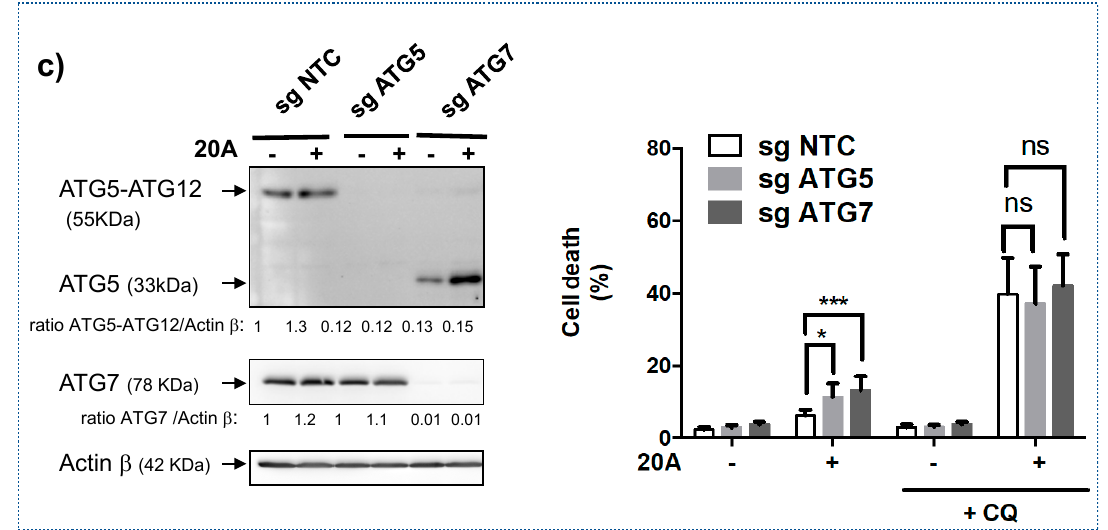
Figure 3. 20A and chloroquine act in concert to trigger cell death. ( a ) HeLa cells (left) and A549 cells (right) were treated with the indicated concentration of 20A with or without 25 µ M of chloroquine for 24 h. Cell death was evaluated by scoring the percentage of propidium iodide (PI) positive cells after flow cytometer analysis. The data represents the mean SD of 6 values obtained from three ± independent experiments each performed in duplicate (** p value < 0.01 using Kruskal-Wallis test, with post-hoc Dunn’s analysis). ( b ) U20S cells were treated with the indicated concentration of 20A with or without 25 µ M of chloroquine for 16 h. Left panel, cell death was evaluated by scoring the percentage of propidium iodide positive cells after flow cytometer analysis. The data represents the mean SD of 9 values obtained from three independent experiments each performed in triplicate ± ( p value **** < 0.0001, using Mann-Whitney test). Right panel , Cell death was evaluated after 16 h treatment with 20A chloroquine by scoring the percentage of TMRM Low / DAPI Low (early apoptosis) ± and TMRM Low / DAPI High (late apoptosis) cells following flow cytometer analysis. The data represents the mean SD of 9 values obtained from three independent experiments each performed in triplicate ± ( p value **** < 0.0001, using Mann-Whitney test). ( c ) Autophagy-proficient (sgNTC) and -deficient (sgATG5 and sgATG7) HeLa cells were treated with 5 µ M 20A either in the presence (25 µ M) or absence of chloroquine for 24 h. Left panel, silencing of key autophagy proteins, ATG5 and ATG7 was checked by western blotting. The western blots were quantified and given as ratio of ATG5-ATG12 / Actin β or ATG7 / Actin β . Right panel, cell death was evaluated by scoring the percentage of propidium iodide positive cells after flow cytometer analysis. The data represents the mean SD of nine values ± obtained from three independent experiments each performed in triplicate ( p value * < 0.05 and p value *** < 0.001, ns: not significant using Mann-Whitney test).